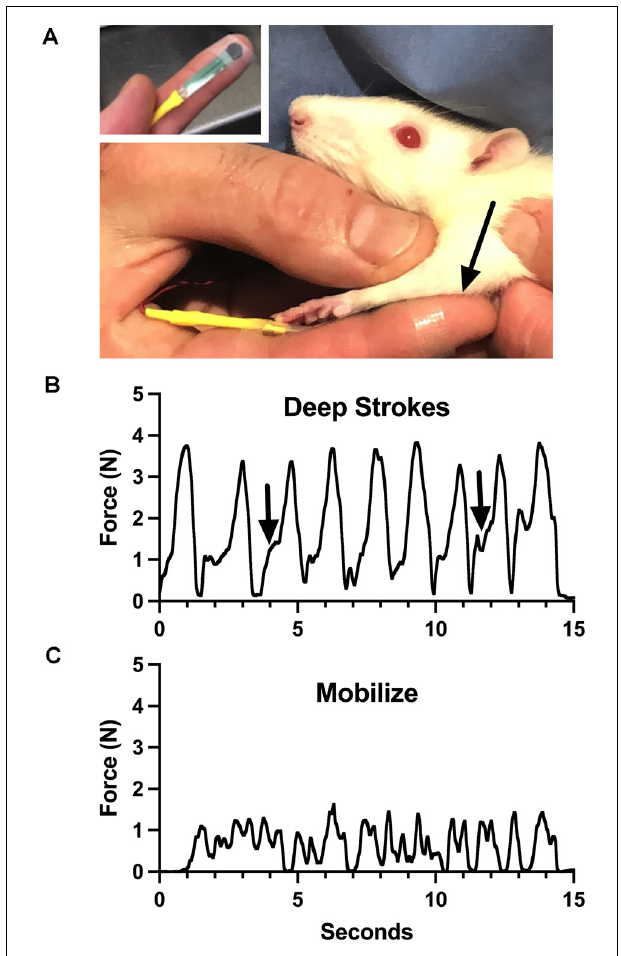
FIGURE 1 | Training device for manual therapy (modified from Barbe et al., 2021). (A) A small pressure-sensitive resistor powered by a bridge amplifier was attached to the therapist’s finger and used to monitor force applied through it to a rat upper limb (arrow). (B) Output during “deep strokes” as depicted in (A) . Arrows indicate skewness of application cycles, where the skin was displaced cephalad to allow deeper penetration without pulling fur. (C) Output during side-side mobilization of the flexor compartment of the arm. See text for more details. Figure 1 reproduced from Barbe et al. (2021) under the Creative Commons Attribution License